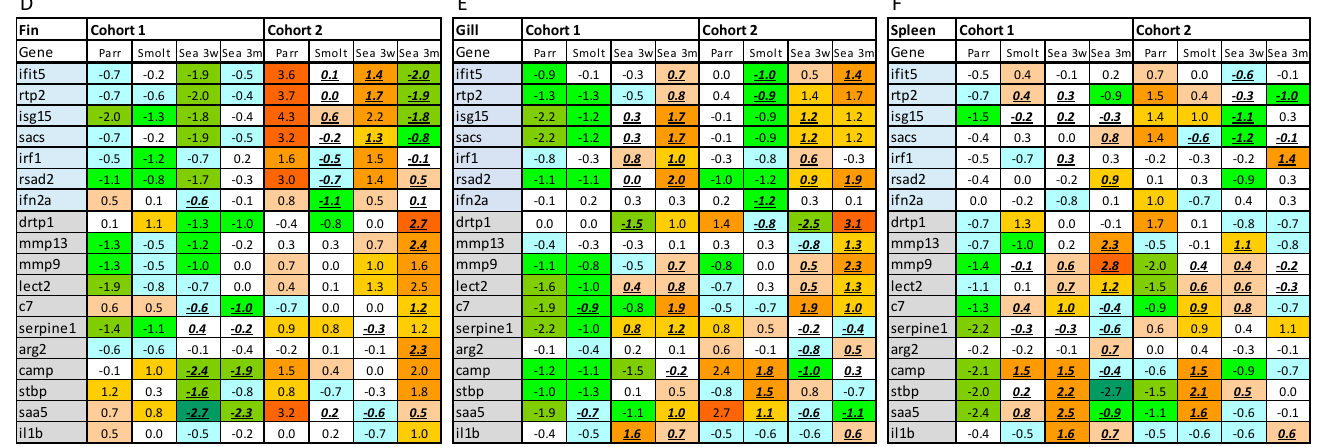
Figure 2. Temporal changes of gene expression in dorsal fin, gill, and spleen. Data are normalized within each cohort so that the mean of each gene in the entire data set is zero. ( A – C ): average expression of immune genes (mean ∆∆ Ct of all genes ± SE) in fin ( A ), gill ( B ), and spleen ( C ) (n = 9–12 individuals at each time-point). Bars within one cohort not sharing the same letters are significantly different (ANOVA, Tukey test, p < 0.05). The dotted lines separate cohorts. ( D – F ): Heatmaps present ∆∆ Ct for selected genes of innate antiviral immunity (VRG) and markers of acute inflammation and stress (AIS) in fin ( D ), gill ( E ), and spleen ( F ): VRG: ifit5 (interferon-induced protein with tetratricopeptide repeats 5), rtp2 (receptor-transporting protein 2), isg15 (interferon-stimulating gene 15), sacs (sacsin), irf1 (interferon regulatory factor 1), rsad2 (radical S-adenosyl methionine domain-containing protein 2, viperin) and ifn2a (interferon 2a). AIS: drtp1 (differentially regulated trout protein 1), mmp13 and 9 (matrix metalloproteinases), lect2 (leukocyte cell-derived chemotaxin 2), c7 (complement component c7), serpine1 (plasminogen activator inhibitor 1), arg2 (arginase-2), camp (cathelicidin), stbp (saxitoxin and tetrodotoxin-binding protein 2-like), saa5 (serum amyloid a-5) and il1b (interleukin-1 beta). Expression differences from the first time-point, parr ( ∆∆ Ct > |0.8|, p < 0.05), are highlighted with underlined bold italics. Comparison of immune gene expression in the gill with the gill reference data set (GRDS) [11] by ∆∆ Ct found deviation greater than 2 σ (2SD) in only three out of 85 analyzed fish, all in cohort 2 and in parr, smolt, and grower after 3 weeks in the sea (Figure 3). The deviations from GRDS were normally distributed (Kolmogorov–Smirnov test).